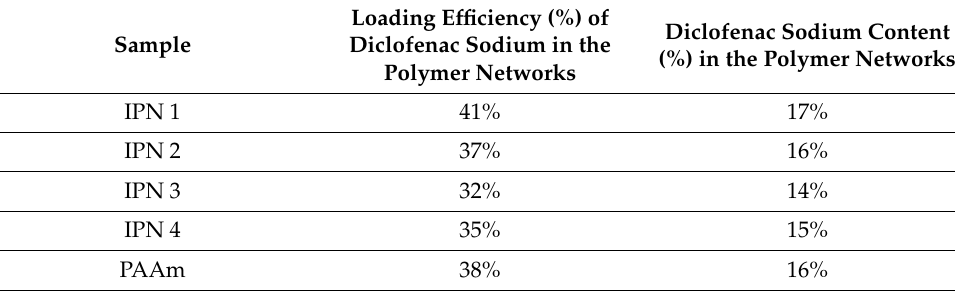
Table 2. Diclofenac sodium loading in PDMAEMA/PAAm IPNs and PAAm single network.